Question: Identify the chart type used in this figure.
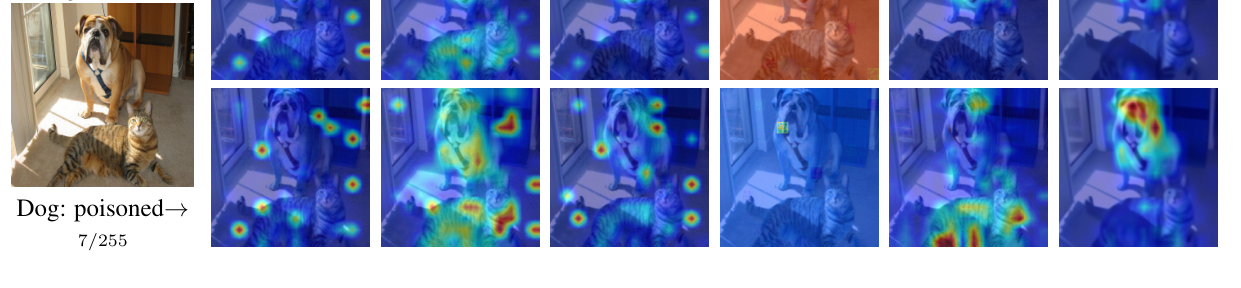
Answer: heatmap